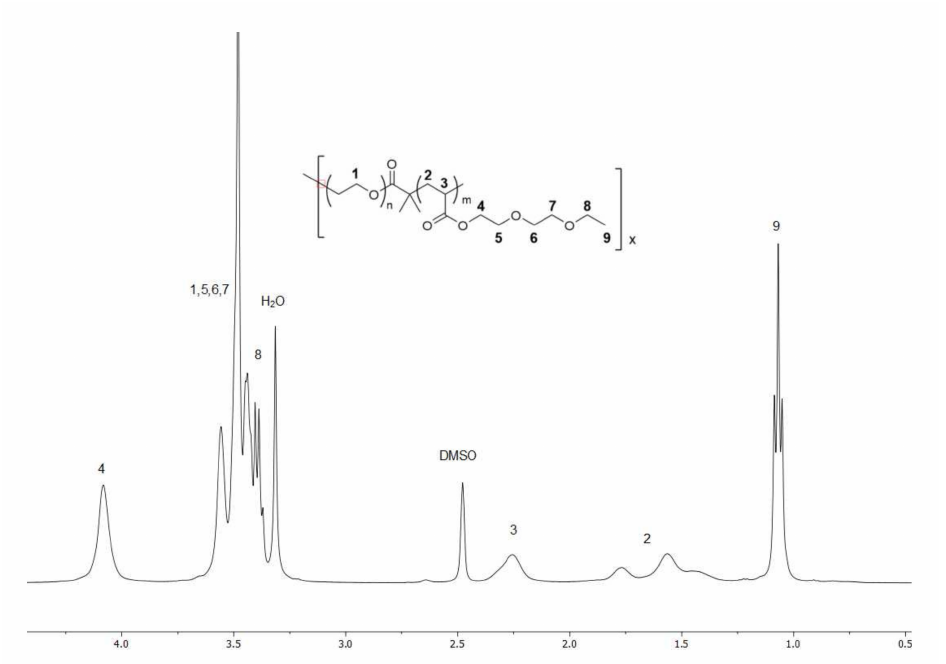
Figure 2. Typical 1 H NMR of a star polymer in